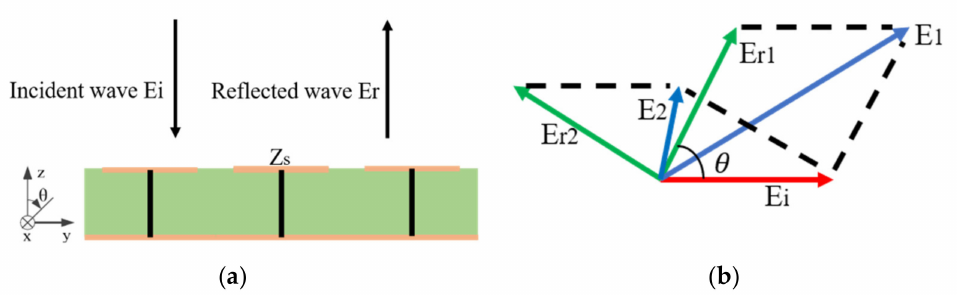
Figure 6. The composed electromagnetic waves obtained from the incident wave and reflected wave: ( a ) the typical schematic picture of the principle of AMC, ( b ) the formation principle schematic picture of the composed electromagnetic